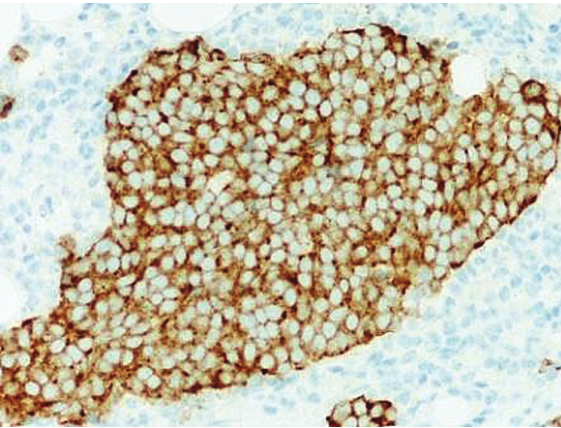
Figure 6: The tumor cells are positive for